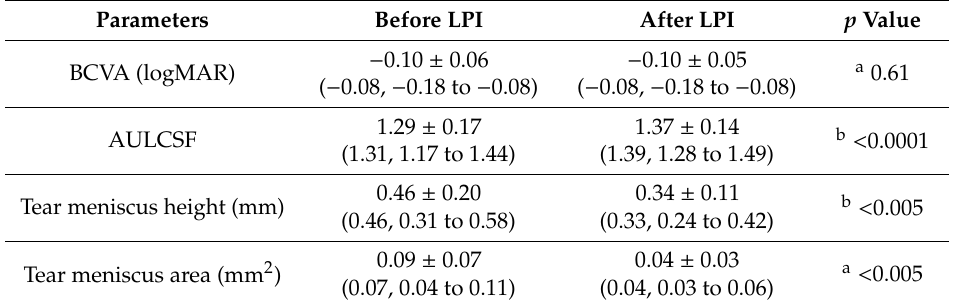
Table 2. Comparison between measured parameters before and after lacrimal passage intubation.